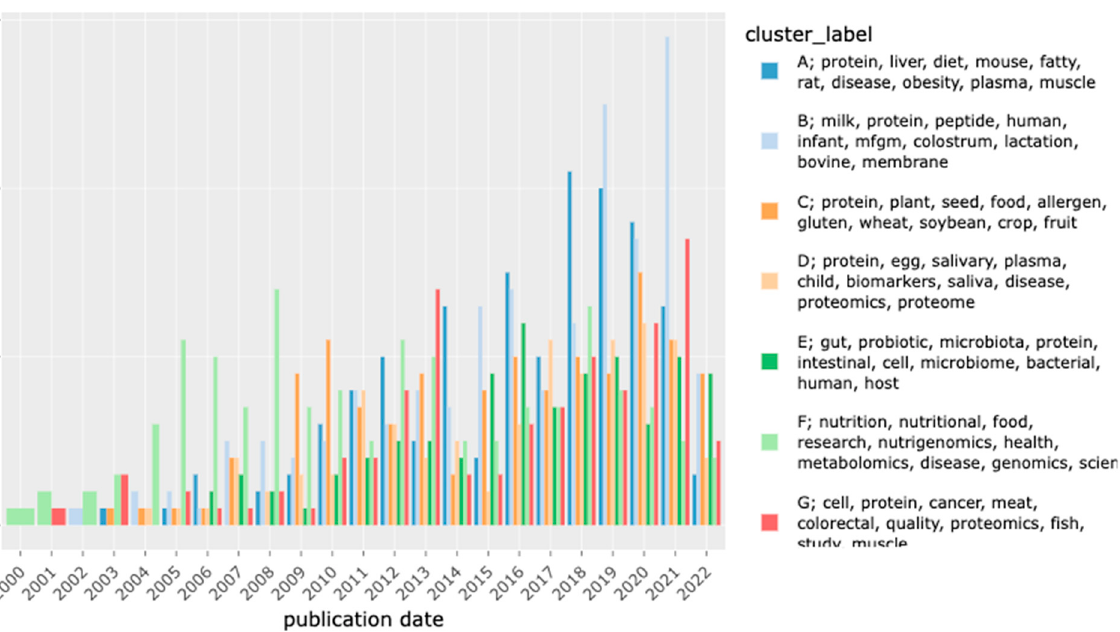
Figure 5. Cluster topics by year from 2000 to 2022. The interactive version of this figure is in Supplement SA, Figure S6.2. Table 3. Protein Enrichment Per Cluster 1.